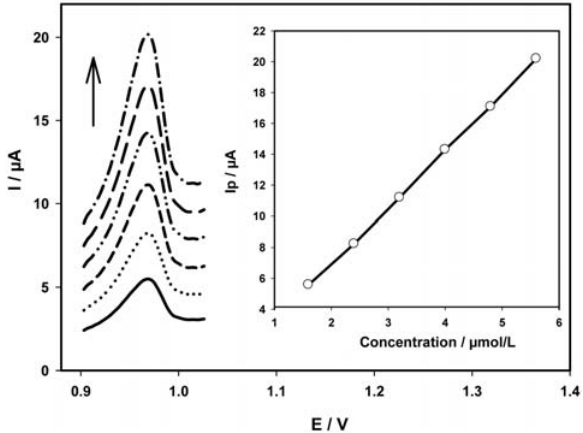
Figure 11: Differential pulse voltammograms for different concen- trations of MET in urine samples at PYCPE in BR buffer (pH 2.0), T = 50 sec and scan rate of 20 mV/s. The inset: the relation bet- acc ween MET concentration and the current